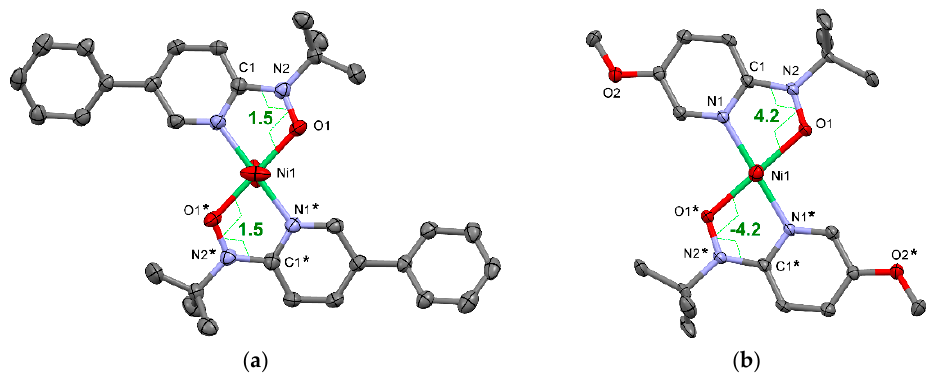
Figure 8. X-ray crystal structures of ( a ) [Ni(phpyNO) 2 (H 2 O) 2 ](ClO 4 ) 2 and ( b ) [Ni(meopyNO) 2 (H 2 O) 2 ](ClO 4 ) 2 measured at 104 and 108 K, respectively. Counter anions and hydrogen atoms are omitted for clarity. Thermal ellipsoids are drawn at the 50% probability level. Selected atomic numbering and torsion angles ( ϕ (Ni–O–N–C sp2 )) are indicated. The molecules possess a two-fold symmetry for ( a ) and a centrosymmetry for ( b ). Adapted with permission from [74,88], published by the American Chemical Society, 2008 and Elsevier, 2009 for ( a ) and ( b ), respectively.